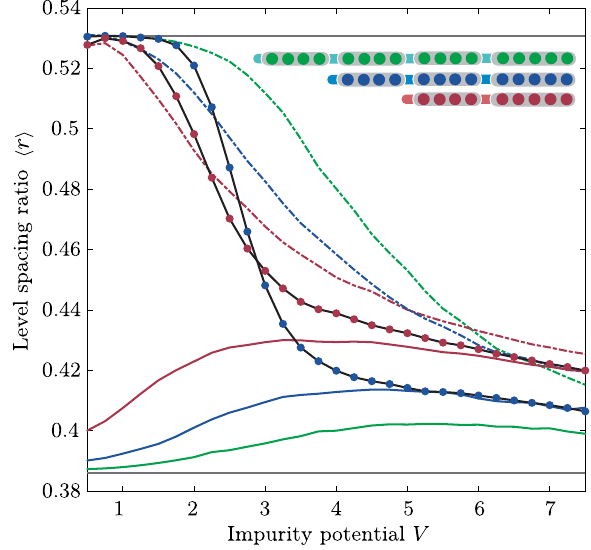
FIG. 8. Finite density level spacing: mean ratio of energy level spacings h r i as a function of the impurity potential for Heisenberg chains of length L ¼ 10 , 15 (red and blue, respectively) with two and three impurities, respectively (black lines with circles). The dash-dotted lines show the level spacing ratio h r i for the effective model where the impurity is frozen. The full lines result from folding the spectrum of the effective model, resulting from the four possible energies associated with the conserved charge of the 17 , the effective impurities. For four impurities, with L eff ¼ model is shown in